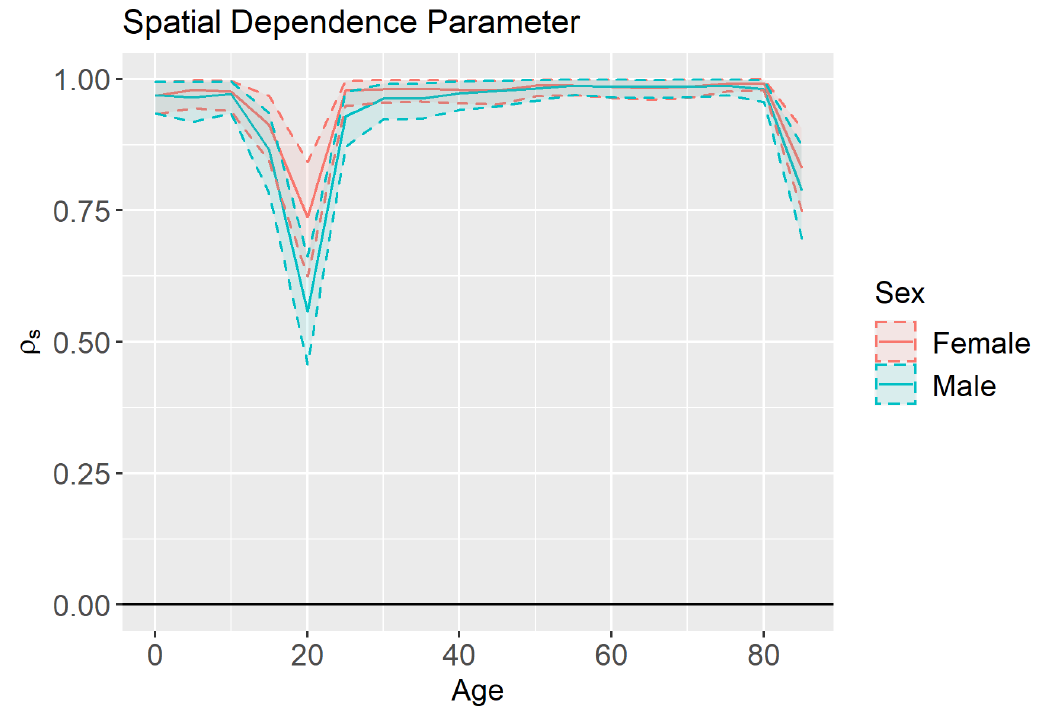
Figure 12. Spatial dependence parameter ( ρ s ) estimates and 95% credible intervals by age and